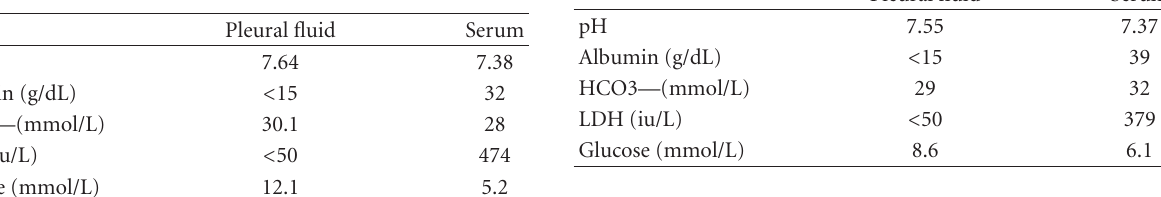
Figure 1: Chest radiograph at presentation. Table 1: Biochemical results.